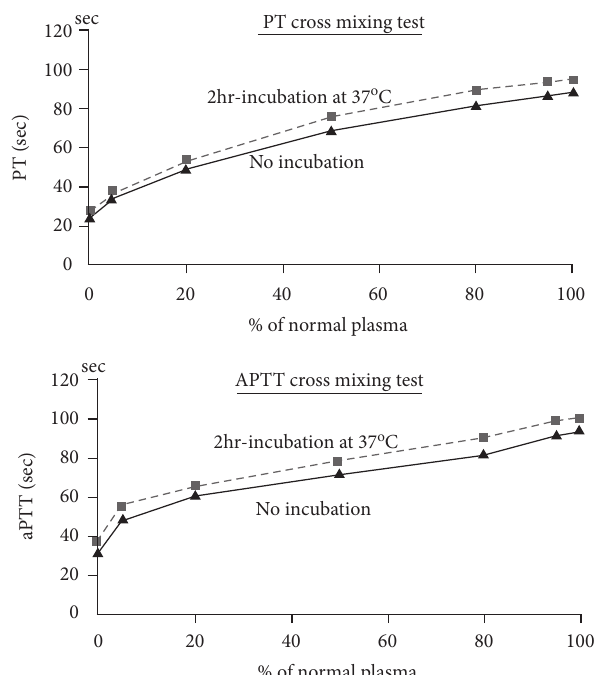
Figure 2: Cross-mixing